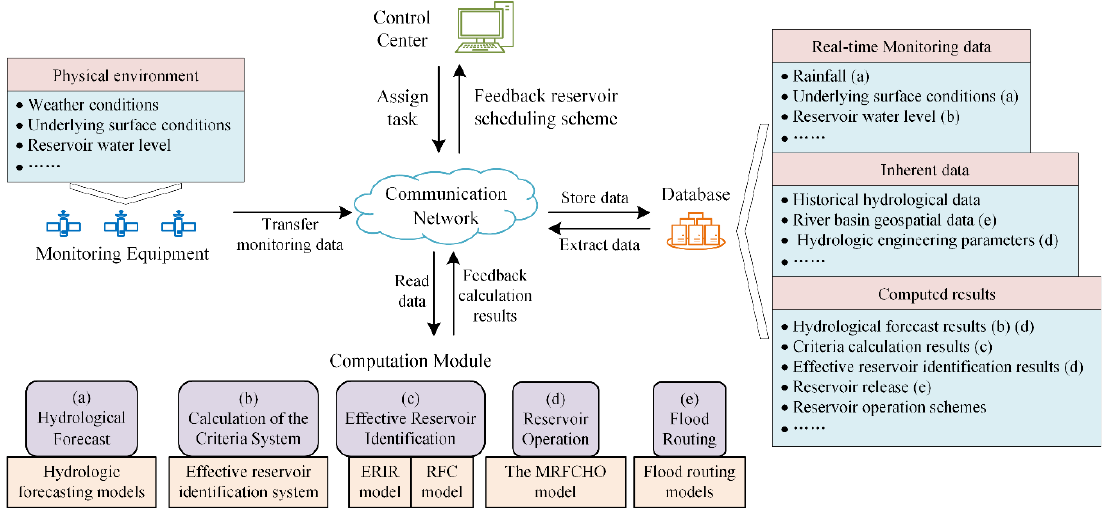
Figure 2. The framework of MRFCHOCPS (Labeling of the data in the database corresponds to the models in the computation module, for example, the data labeled (a) are the input to model (a)).